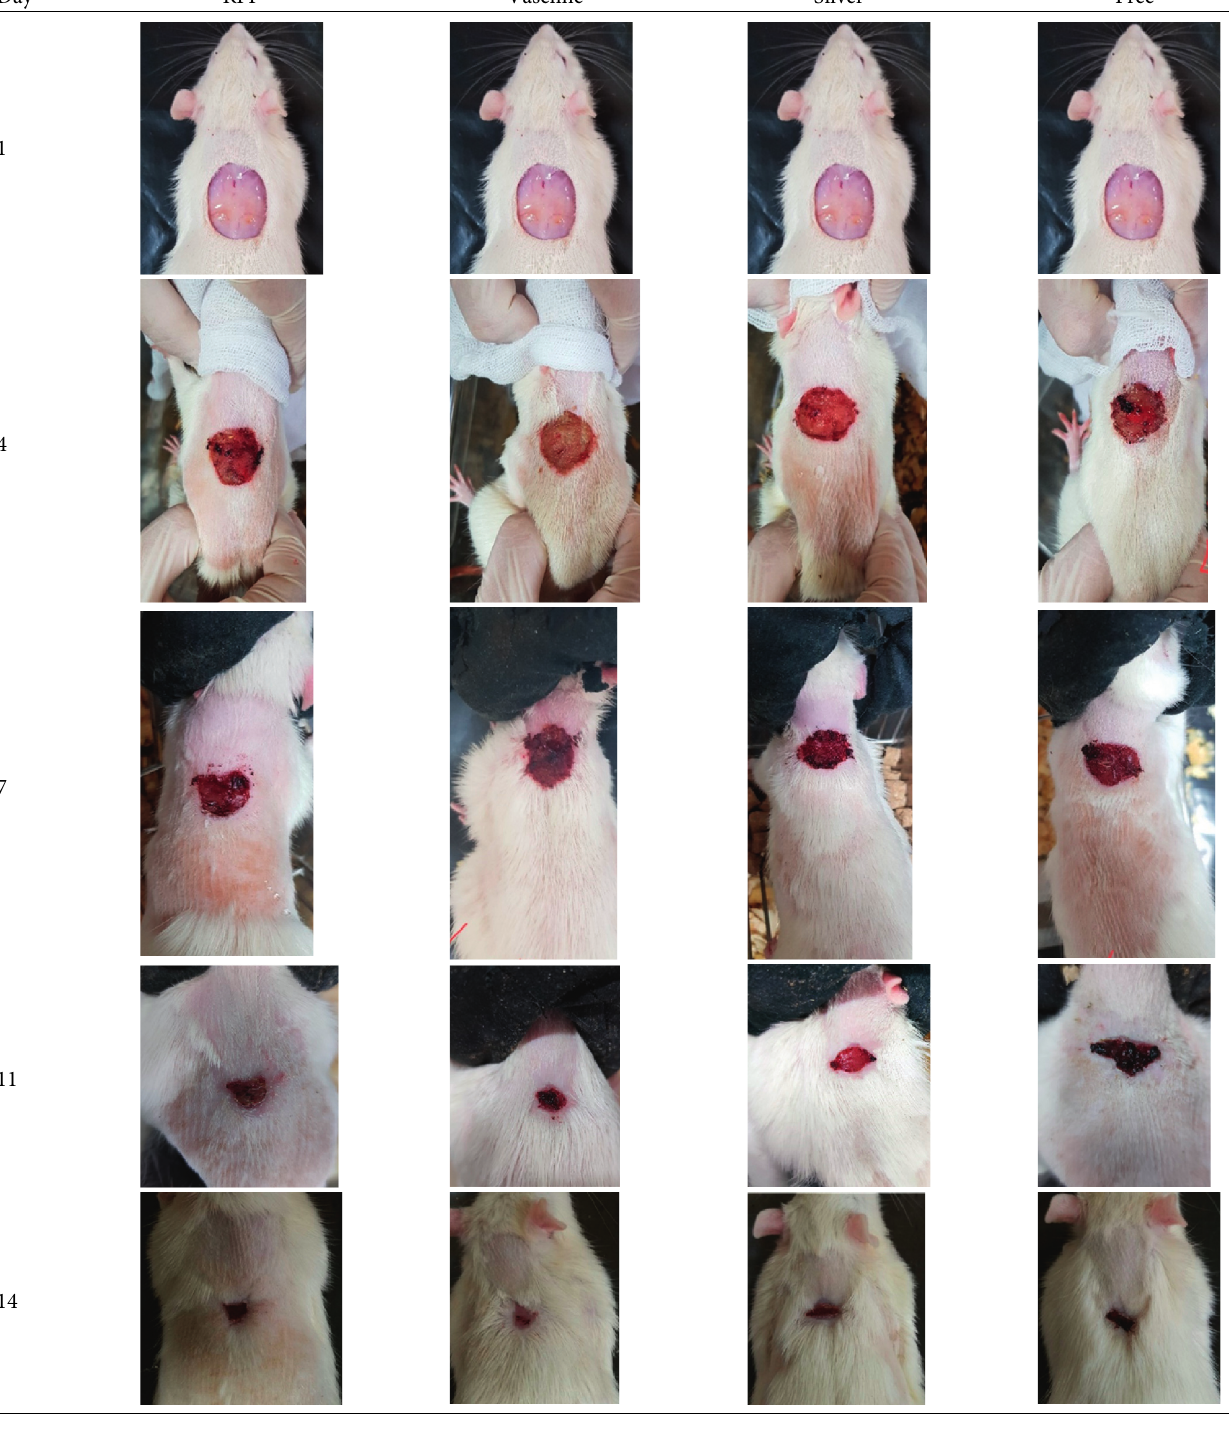
Table 4: Wound analysis in RFF, Vaseline, silver, and free groups on days 1, 4, 7, 11, 14, and 21 (the full thickness wound induced in all groups at day one and there is no difference between